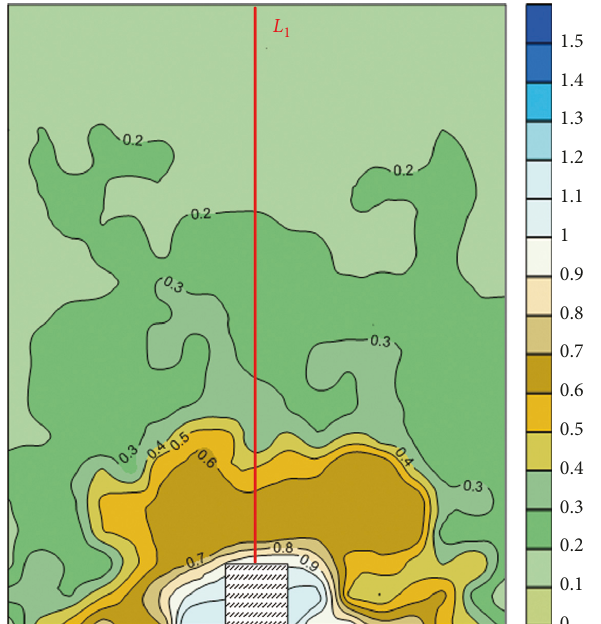
Figure 8: The contour map of ζ on T0.